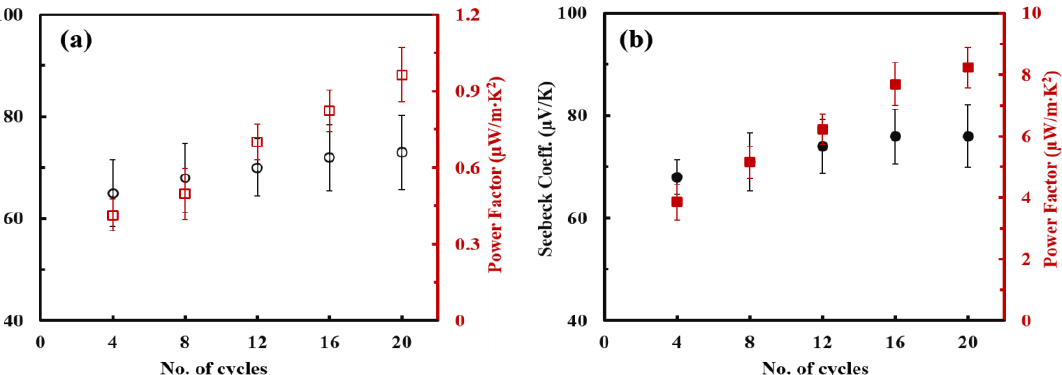
Figure 6. Seebeck coefficient and power factor of PANi/SWNT-PEDOT:PSS thin films that are coated by ( a ) dipping and ( b ) spraying methods.